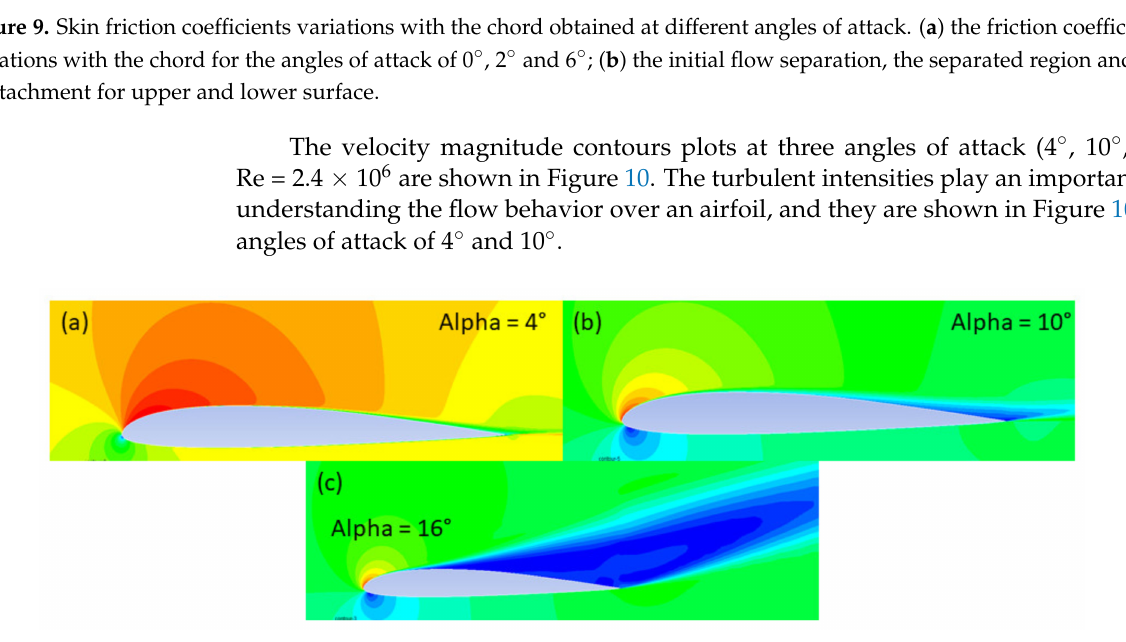
Figure 10. Velocity magnitude contour plots at three angles of attack at Re = 2.4 × 10 6 . ( a ) the contour lines at low angles of attack such as 4 ◦ ; ( b ) the contour lines at low angles of attack such as 10 ◦ ; ( c ) a fully separated flow at the angle of attack of 16 ◦